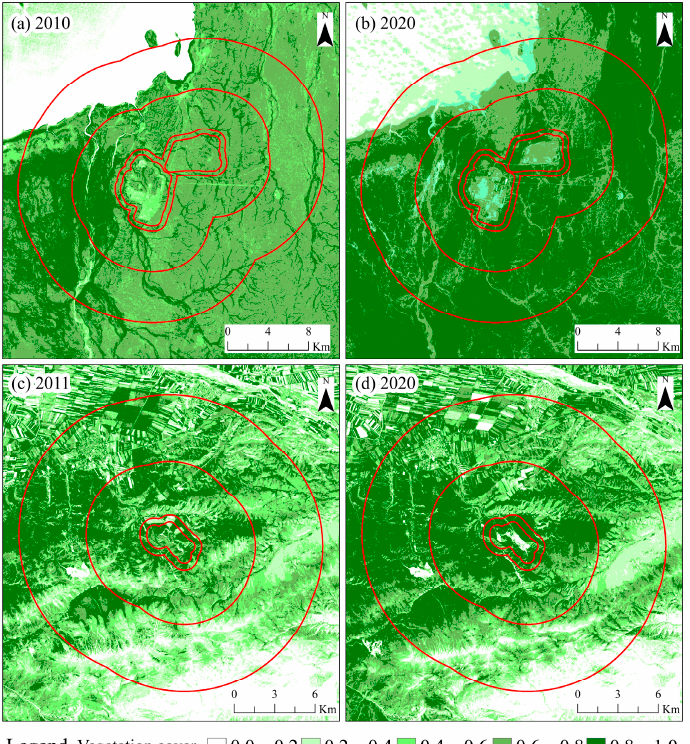
Figure 4. Distribution of vegetation cover in different periods in mining areas ( a , b ) for Sino Iron and ( c , d ) for Taldybulak Levoberezhny.